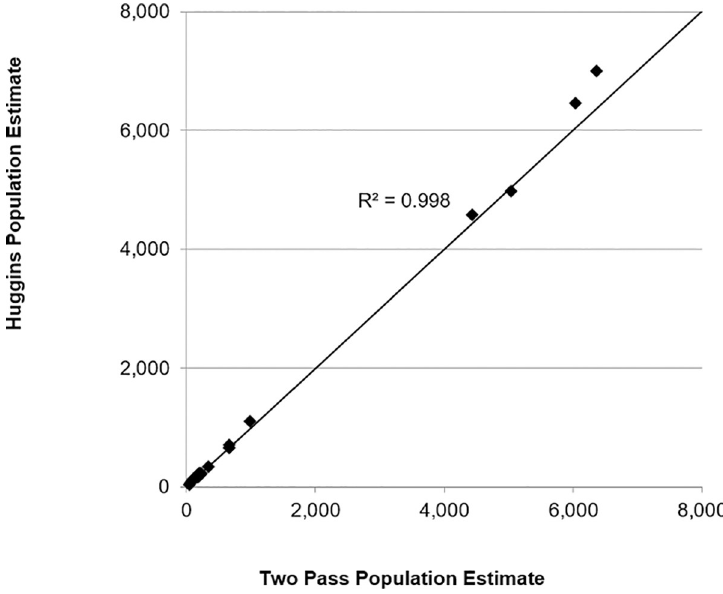
Fig 2. Relationship of population estimates from a three pass Huggins Closed Capture model in Program MARK (with time effect that allowed for varying capture probabilities) and the simple two pass model of that assumes a constant capture